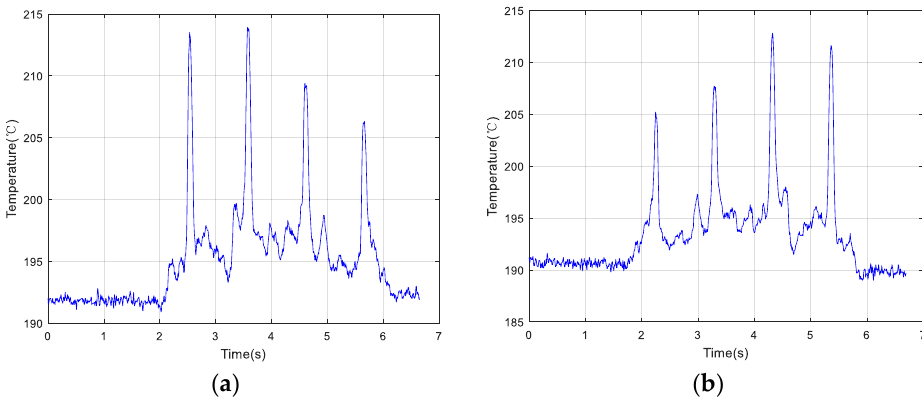
Figure 11. Collected temperature data of the four cracks scanned by the optical head at 10.0 mm/s along the ( a ) positive direction and ( b ) opposite direction.